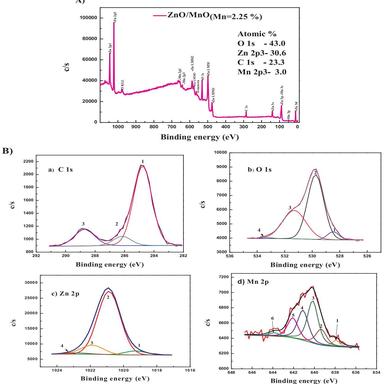
A) XPS spectrum of ZnO/ MnO(Mn=2.25%) nanocomposite, B) XPS and Gaussian fits for: b) C 1 s, c) O 1 s, d) Zn 2p and e) Mn 2p of ZnO/ MnO(Mn=2.25%) nanocomposite.